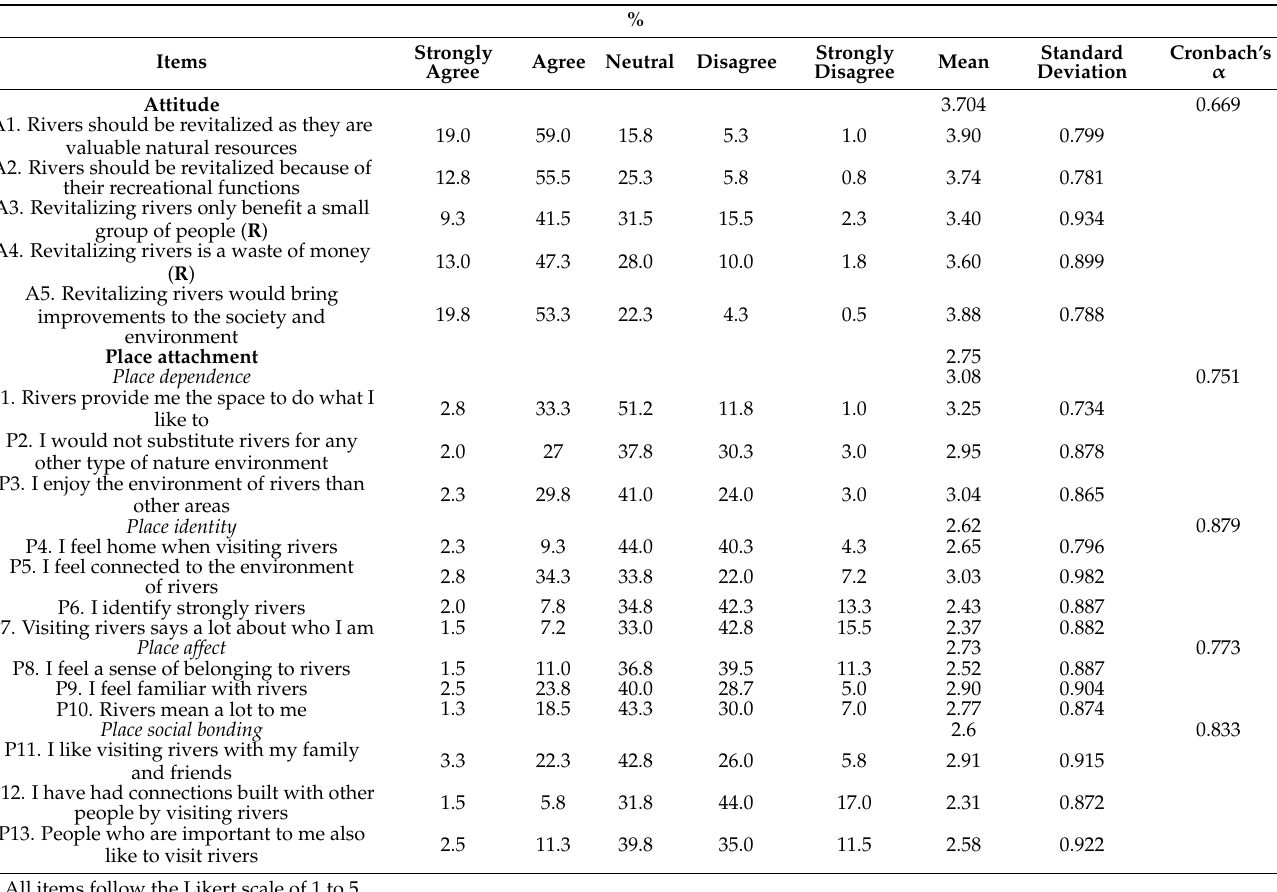
Table 2. Summary of attitude and place attachment of respondents on urban rivers and river